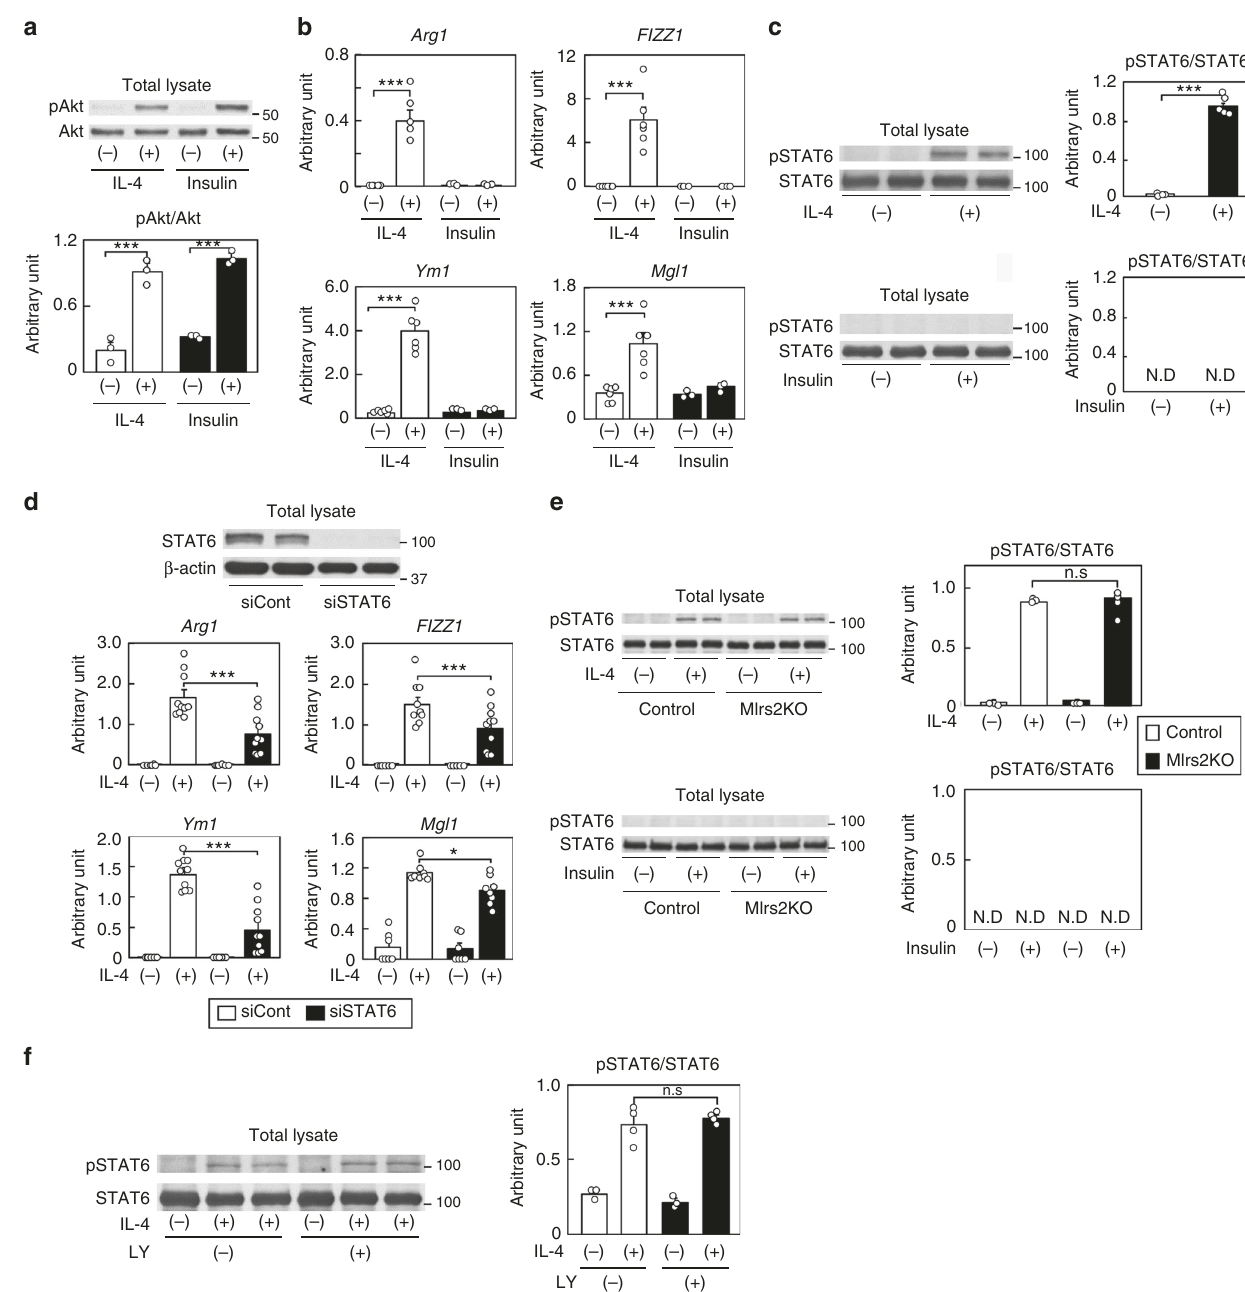
Fig. 6 IL-4-induced M2a-subtype M Φ activation was regulated by both the Irs2 and STAT6 pathways. a Akt phosphorylation and protein levels in the BMDM of the C57BL/6 mice after IL-4 or insulin stimulation ( n = 3 – 4). b Expression levels of the M2a-subtype M Φ marker genes in the BMDM of the C57BL/6 mice after IL-4 or insulin stimulation ( n = 4). c STAT6 phosphorylation and protein levels in the BMDM of the C57BL/6 mice after IL-4 or